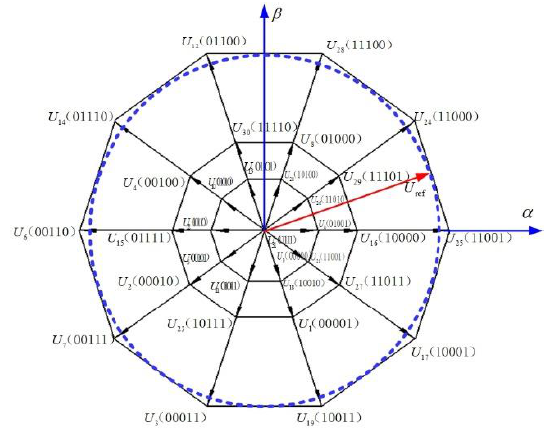
Figure 3. Voltage vector distribution of a five-phase voltage source inverter.